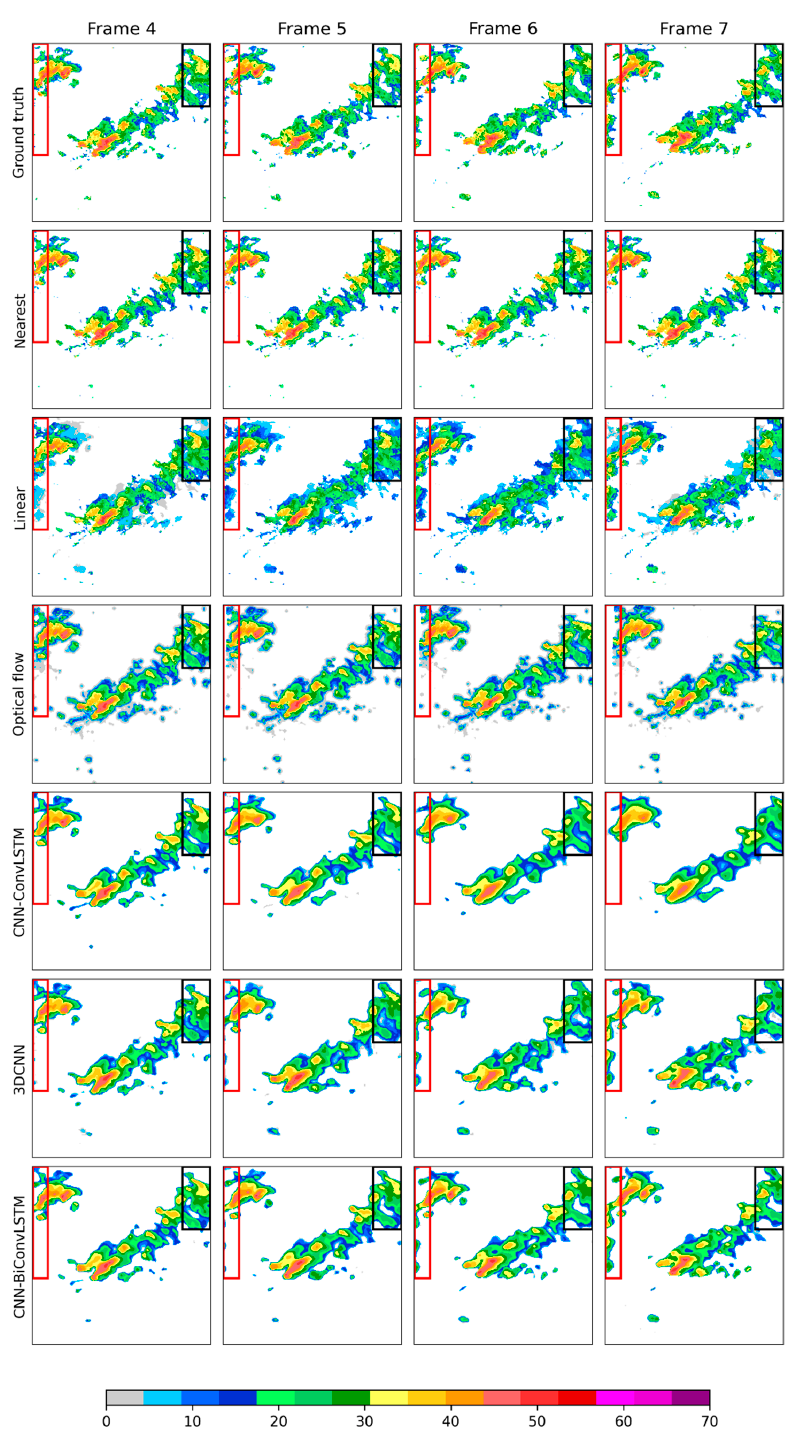
Figure 7. Comparison of different models in reconstructing missing radar frames for the missing pattern of ‘1110000111’. The 1st line shows the fourth to the 7th input radar images (ground truths); the 2d to the 7th lines show the reconstructed radar images from different models.